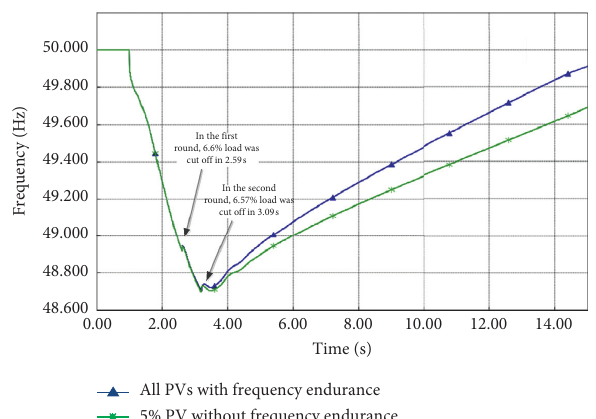
Figure 5: Influence of frequency endurance capability of the distributed photovoltaic generation on low-frequency load shedding control effect.